Question: Which kind of chart has been used to present this data?
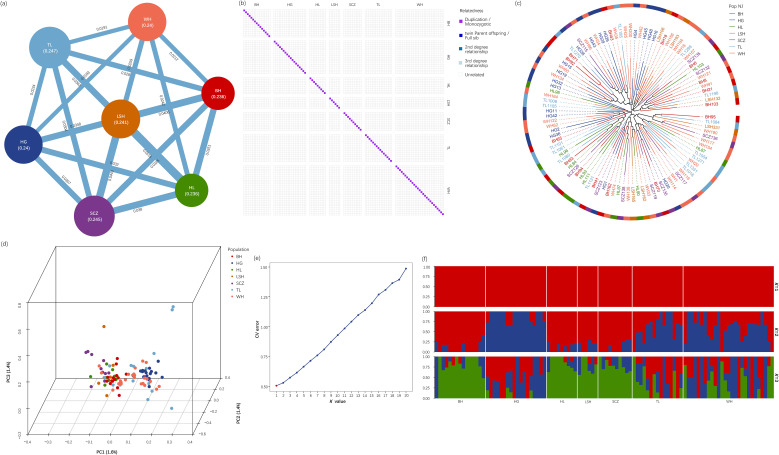
Answer: heatmap